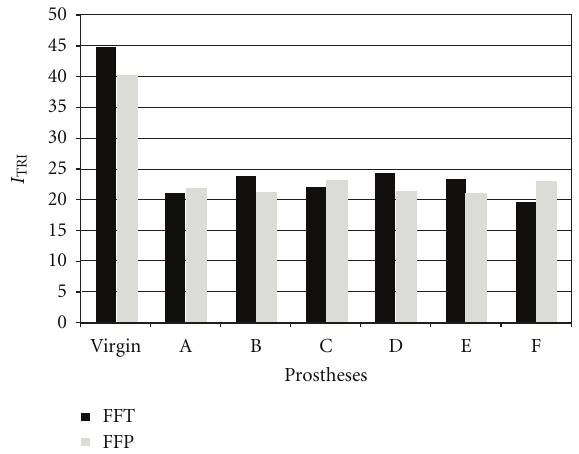
Figure 16: Variation of the cyclic oligomers. I TRI is the integral peaks values of the cyclic